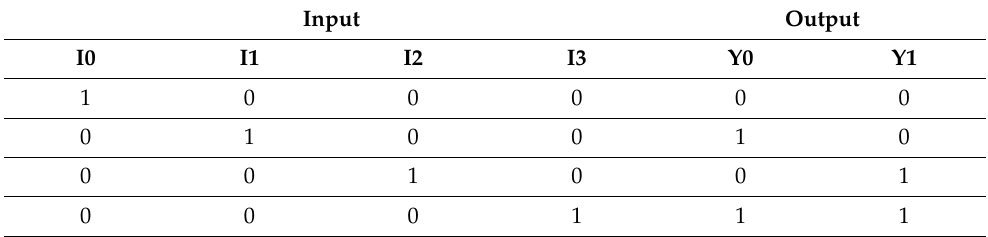
Table 2. Truth table of the proposed 4 × 2 encoder.